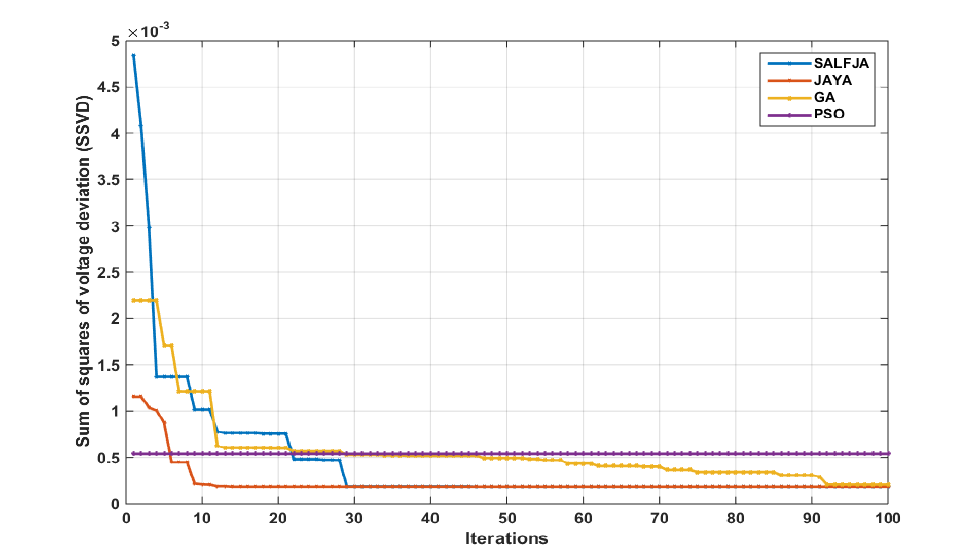
Figure 3. IEEE 15 bus system-Validation with convergence characteristics. Figure 4 depicts the voltage at each bus in the IEEE 15 bus test system. The voltage at each bus was lower in the absence of DG units in the system than in the presence of DG units owing to reverse power flow, which reduced losses and improved the voltage profile.